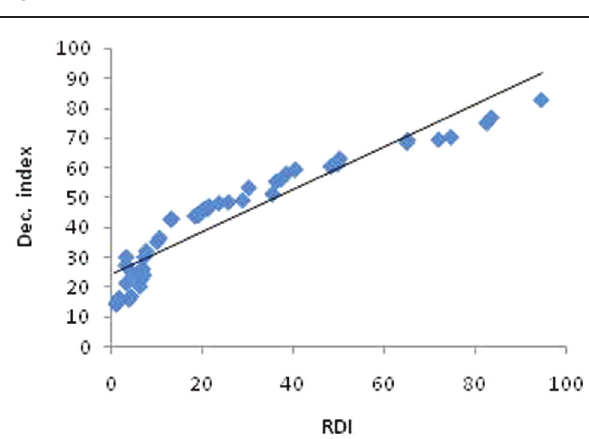
Correlation between deceleration index (PTT Ar) and RDI. Dec., deceleration; PTT Ar, PTT arousal index; RDI, respiratory